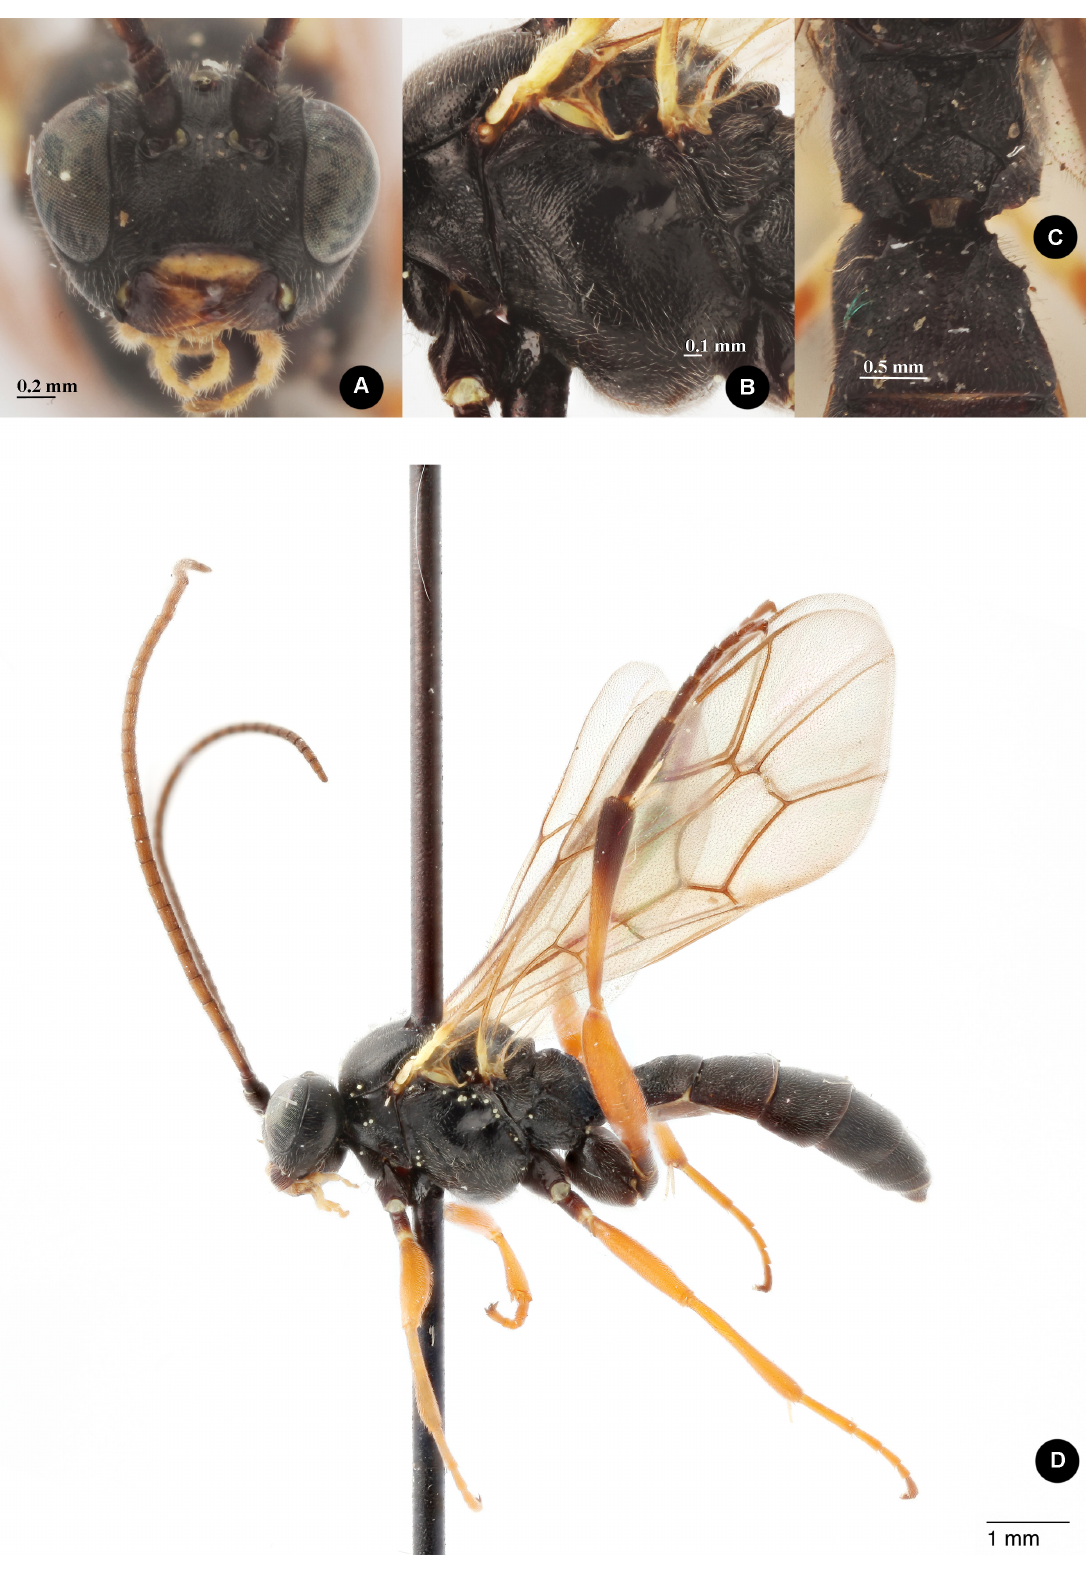
Fig. 6. Rhinotorus jussilai sp. nov., holotype, ♀. A . Face. B . Mesopleuron. C . Propodeum and first metasomal tergite dorsally. D .